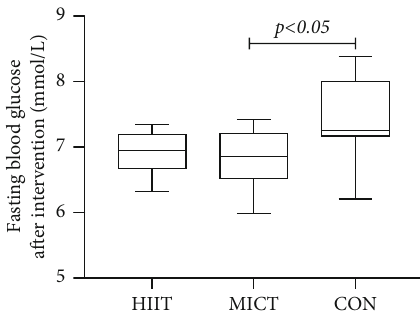
Figure 5: Comparison of di ff erence of VO intervention.